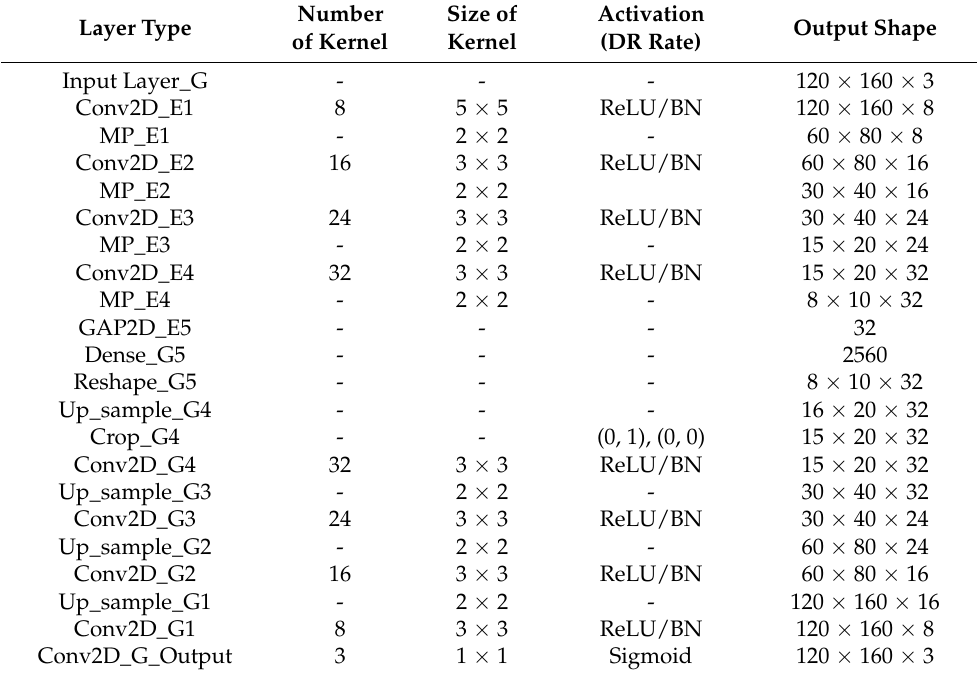
Table 2. The detailed structure of the WAR model.